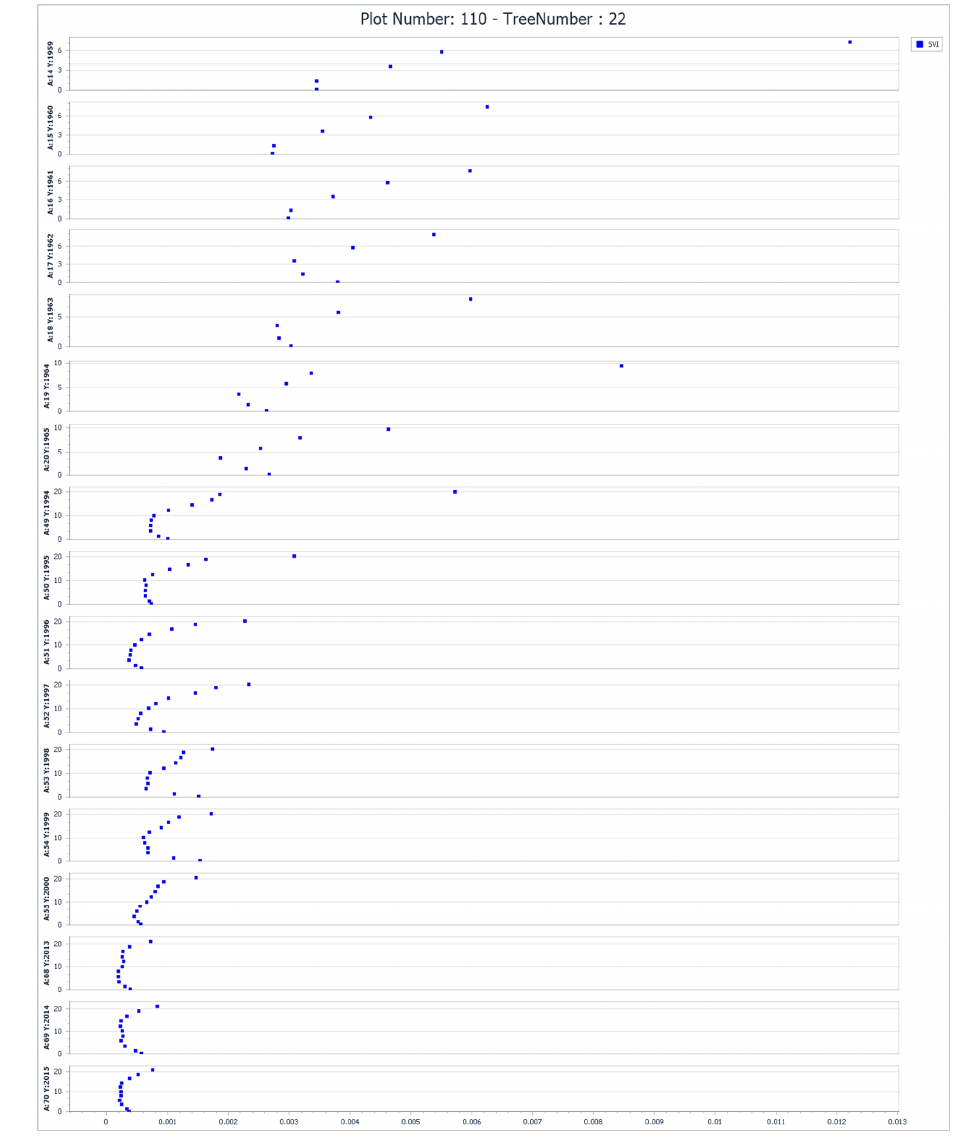
Figure 7. Specific volume increment profile derived from a 70 year-old jack pine tree illustrating the distribution of relative responses throughout the stem for the 3 years prior to the 1st and 2nd thinnings (1959–1961 and 1994–1996, respectively), the year of thinning treatments (1962 and 1997), the following 3 years after the 1st and 2nd thinnings (1963–1965 and 1998–2000, respectively), and the final 3 years